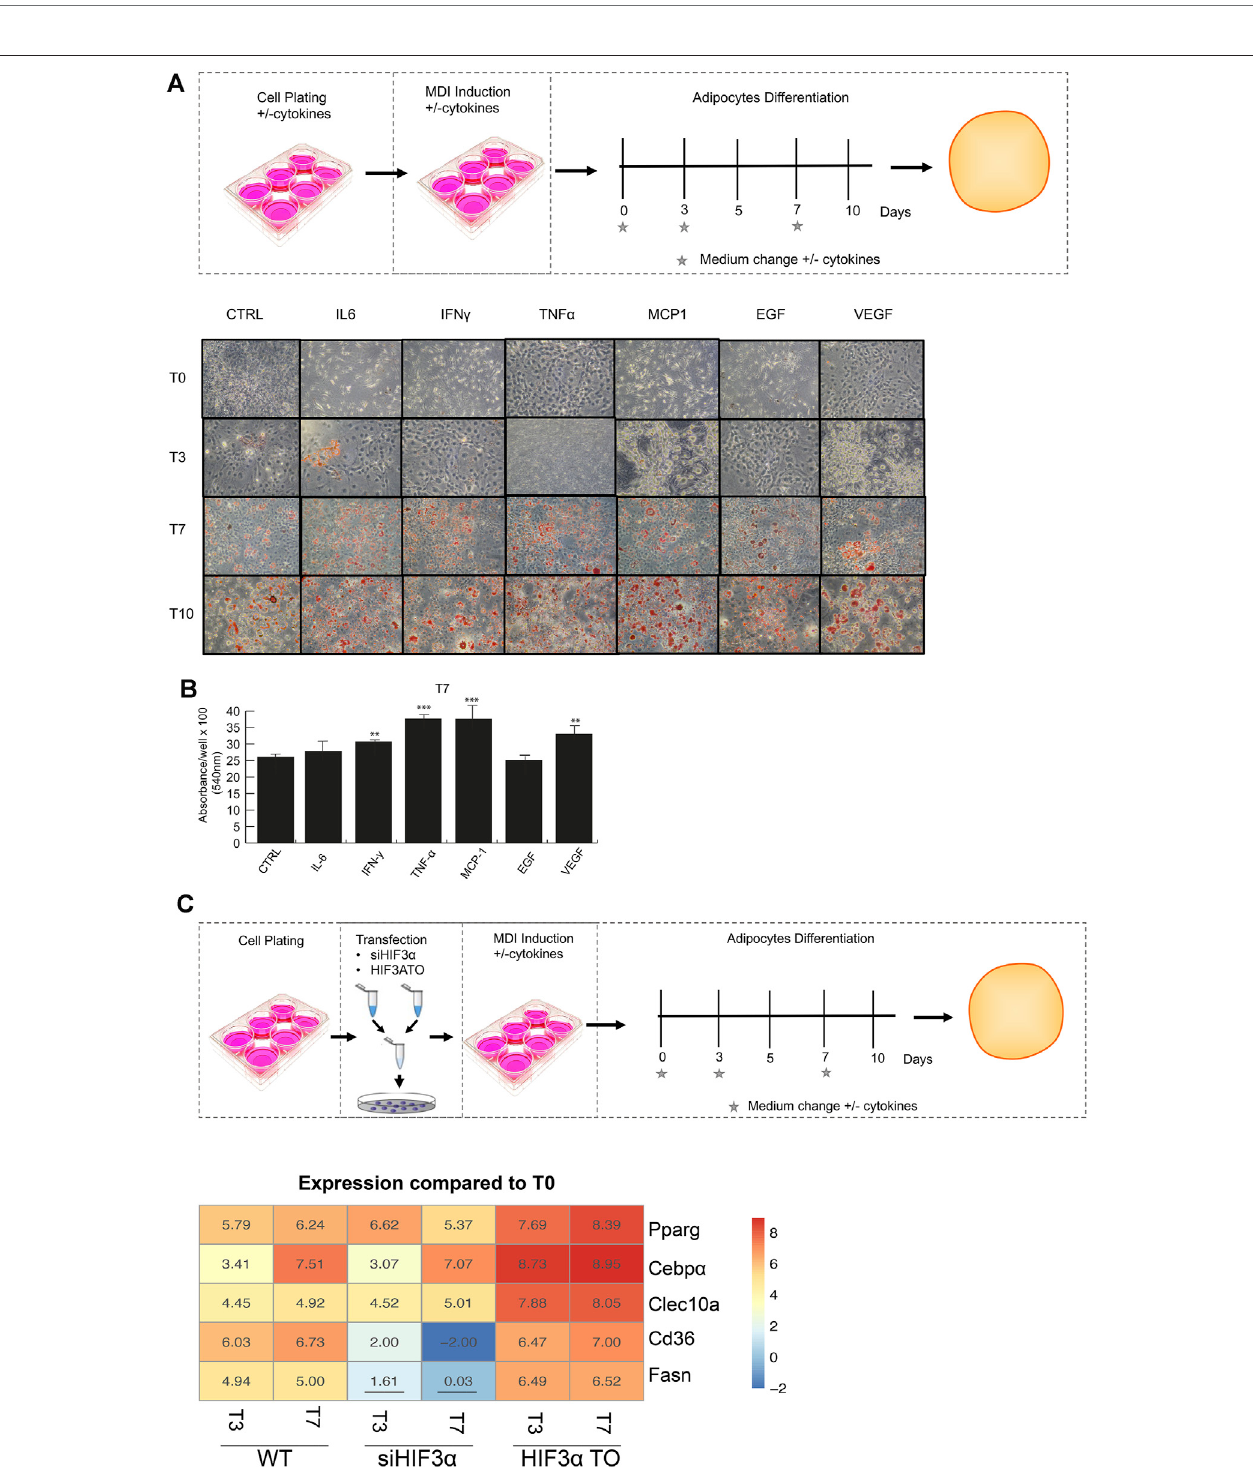
FIGURE 1 | Modulation of Hif3 α expression regulates the adipocyte differentiation toward WAT phenotype. (A) Schematic representation of experimental design. 3T3-L1 cells were plated in presence and absence of pro-in fl ammatory cytokines the day before the differentiation induction until the appearance of mature adipocytes (T0toT10).RepresentativeOilRedO-stainingbylightmicroscopyinourexperimentalcondition. (B) Quanti fi cationofOilRedO-stainingat540 nm( n (cid:2) 3)usingaTECAN roboticstationinmatureadipocytesatday7.*** p ≤ 0.001,** p ≤ 0.01 vs .control. (C) Schematicrepresentationoftransfectiondesignandgeneexpressionanalysis ( Pparg, C/ebp α , Clec10a, Cd36, Fasn ) in WT, si Hif3 α and HIF3A TO adipocytes. Heatmap represents expression pro fi le of WAT genes differentially expressed during adipogenesis. Values represent the means of the fold change vs. T0WT ( n (cid:2) 3). T0WT is calculated as 1, thus > 1 means upregulation, < 1 means downregulation. All values are signi fi cant ( p ≤ 0.01) except those underlined.